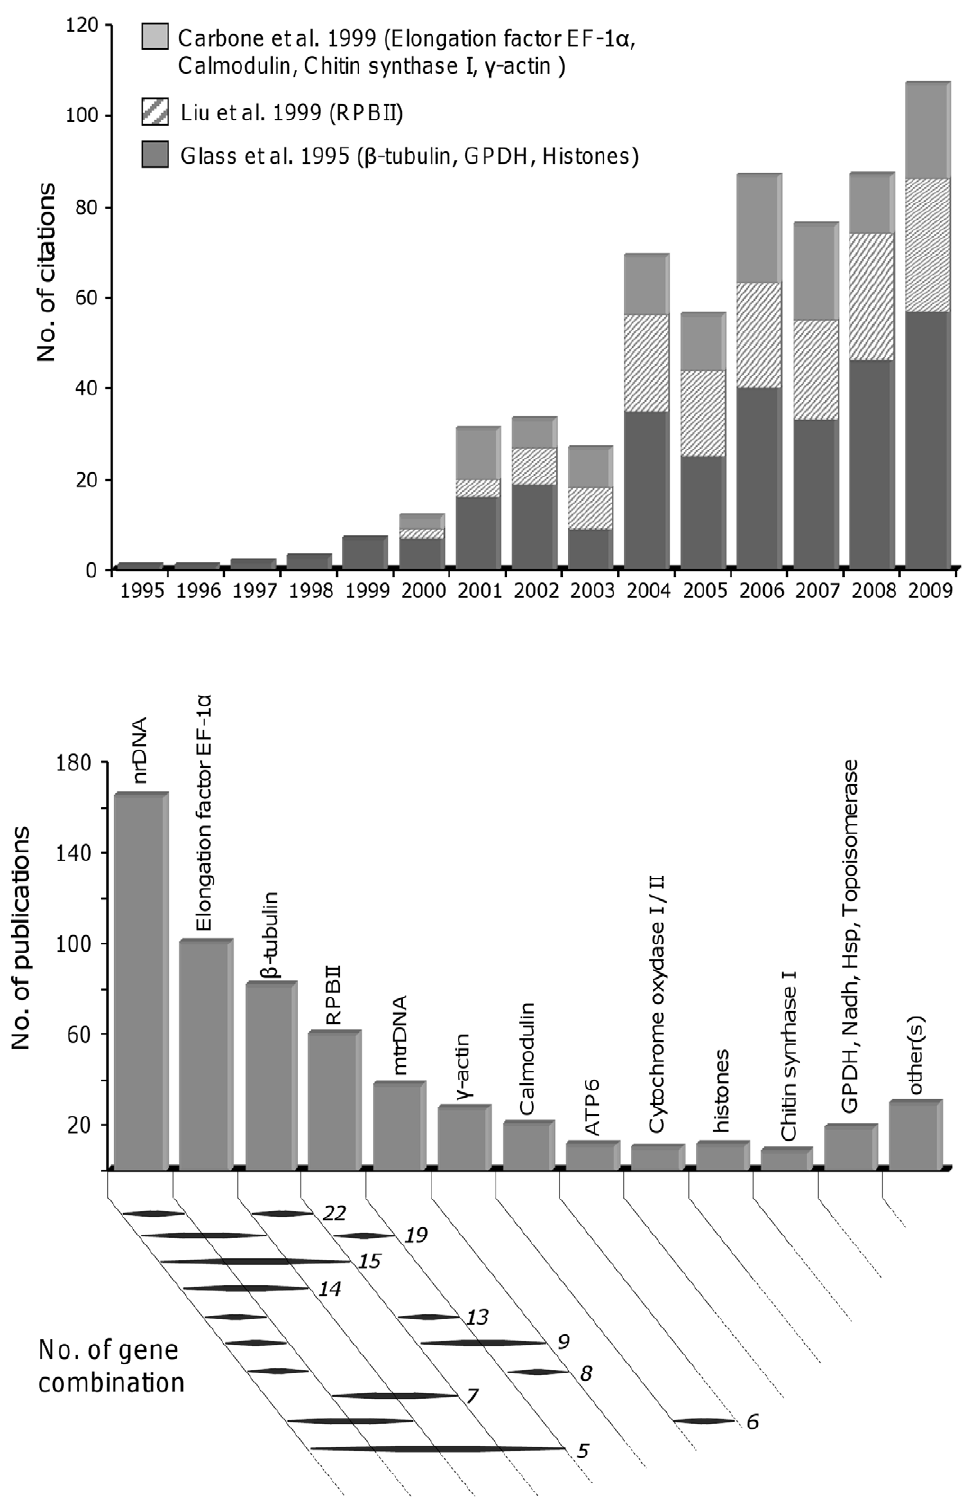
Figure 1. Genes most commonly used in fungal multigene phylogenies. Data were compiled from 196 multigene phylogenies published between 1996 and 2009 retrieved in ISI Thompson Reuters using the following keywords: ‘‘fungi’’ OR ‘‘fungal’’ AND ‘‘multigene’’ or ‘‘multilocus’’ AND ‘‘phylogeny’’. A, distribution of genes/number of publications; B, occurrence of the ten most commonly gene combination used among the 196 studies.